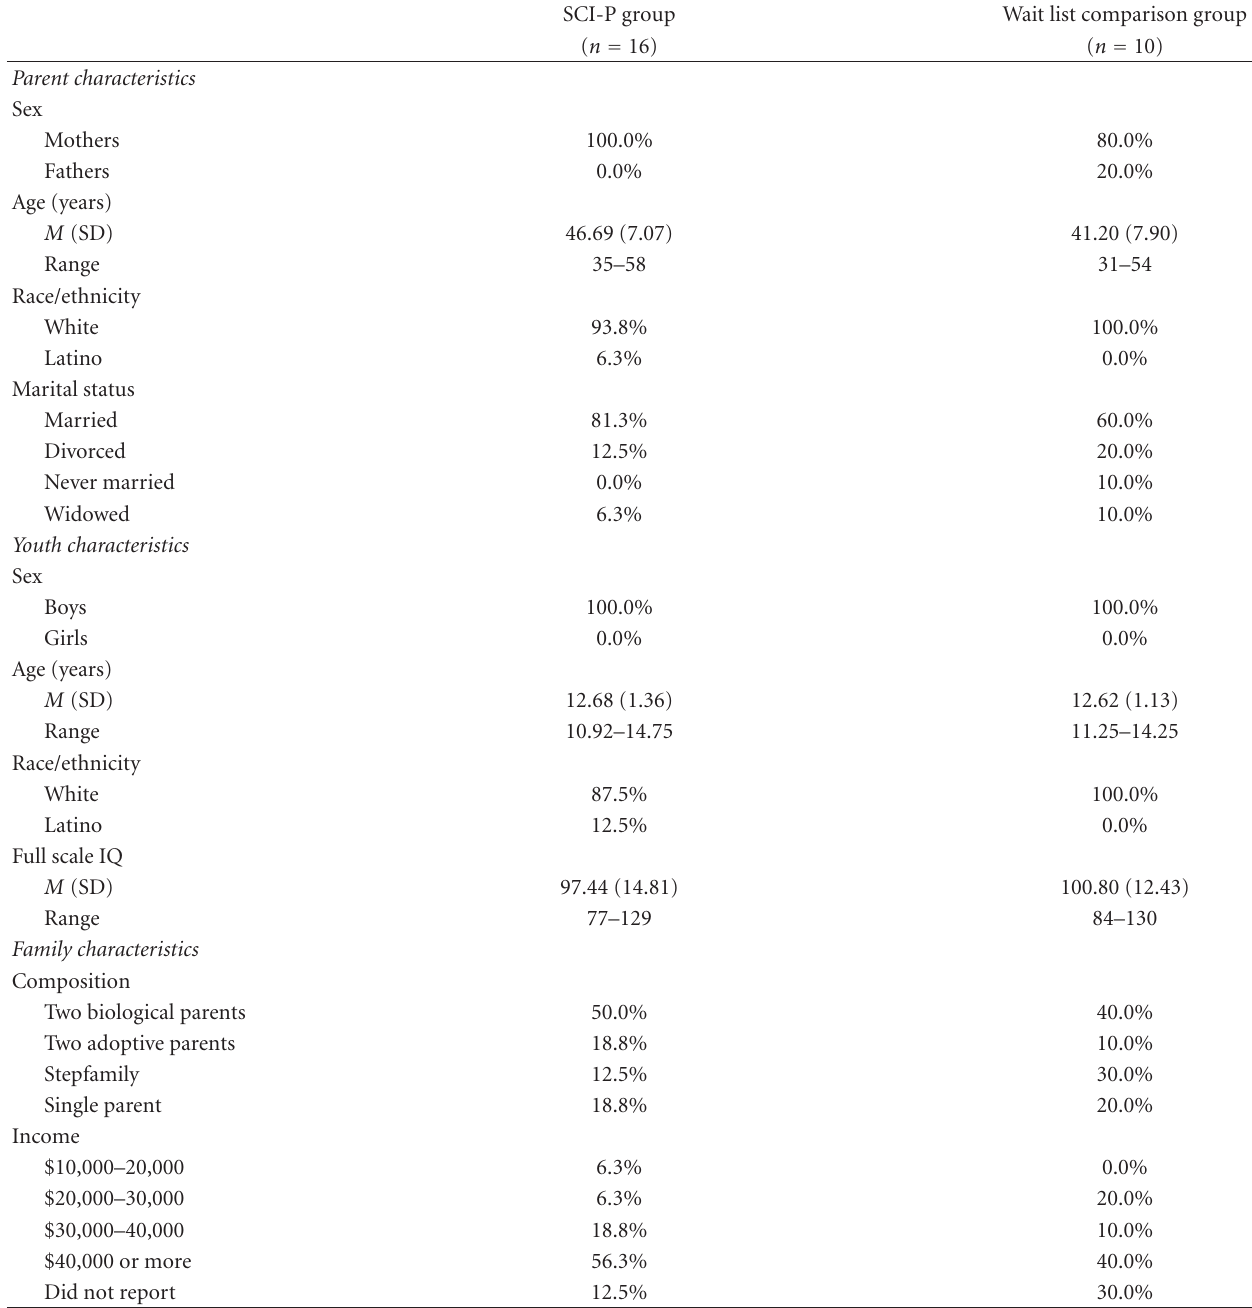
Table 1: Participant demographic